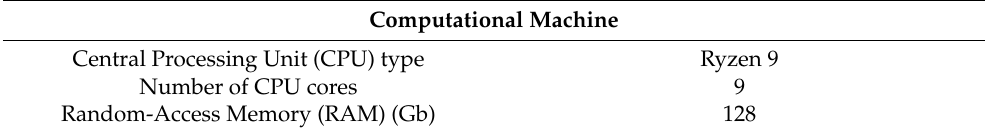
Table 6. The parameters of the computational machine.